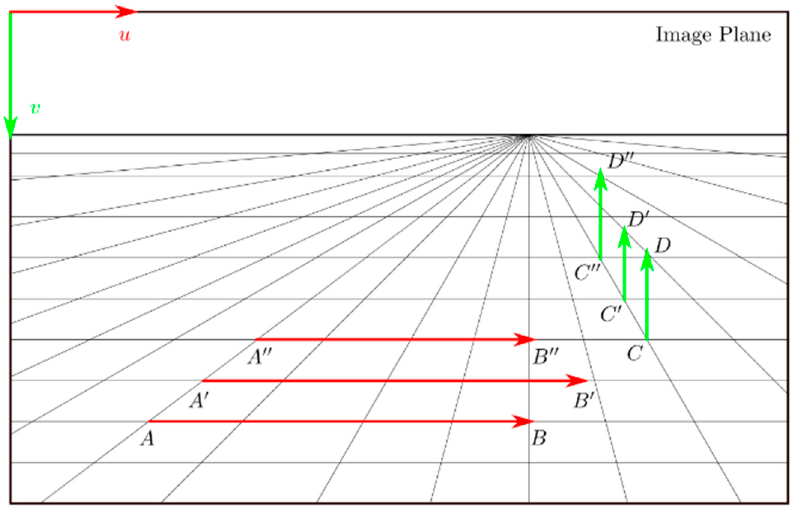
Figure 10. Graphical representation of the issue of representing speeds in the image plane or in the the 3D environment. In the image plane, the following relations are true AB = A (cid:48) B (cid:48) > A (cid:48)(cid:48) B (cid:48)(cid:48) and 3D environment. In the image plane, the following relations are true (cid:1827)(cid:1828) (cid:3364)(cid:3364)(cid:3364)(cid:3364)(cid:3364) = (cid:1827)’(cid:1828)’(cid:3364)(cid:3364)(cid:3364)(cid:3364)(cid:3364) (cid:3408) (cid:1827)′′(cid:1828)′′(cid:3364)(cid:3364)(cid:3364)(cid:3364)(cid:3364)(cid:3364)(cid:3364) and (cid:1829)(cid:1830) (cid:3364)(cid:3364)(cid:3364)(cid:3364)(cid:3364) = (cid:1829)′′(cid:1830)′′(cid:3364)(cid:3364)(cid:3364)(cid:3364)(cid:3364)(cid:3364)(cid:3364) (cid:3408) (cid:1829)′(cid:1830)′(cid:3364)(cid:3364)(cid:3364)(cid:3364)(cid:3364)(cid:3364) , while in the actual environment (cid:1827)(cid:1828) (cid:3364)(cid:3364)(cid:3364)(cid:3364)(cid:3364) = (cid:1827)′′(cid:1828)′′(cid:3364)(cid:3364)(cid:3364)(cid:3364)(cid:3364)(cid:3364)(cid:3364) (cid:3407) (cid:1827)′(cid:1828)′(cid:3364)(cid:3364)(cid:3364)(cid:3364)(cid:3364)(cid:3364) and (cid:1829)(cid:1830) (cid:3364)(cid:3364)(cid:3364)(cid:3364)(cid:3364) = (cid:1829) (cid:4593) (cid:1830) (cid:4593) (cid:3364)(cid:3364)(cid:3364)(cid:3364)(cid:3364)(cid:3364) (cid:3407) (cid:1829)′′(cid:1830)′′(cid:3364)(cid:3364)(cid:3364)(cid:3364)(cid:3364)(cid:3364)(cid:3364) are true CD = C (cid:48)(cid:48) D (cid:48)(cid:48) > C (cid:48) D (cid:48) , while in the actual environment AB = A (cid:48)(cid:48) B (cid:48)(cid:48) < A (cid:48) B (cid:48) and CD = C (cid:48) D (cid:48) < C (cid:48)(cid:48) D (cid:48)(cid:48) are true instead.